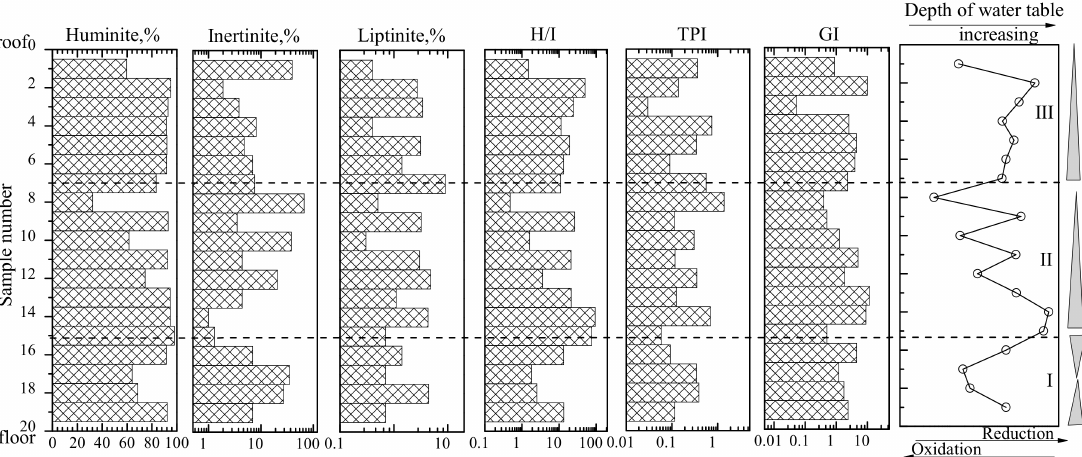
Figure 18. Vertical variations of the indices of the maceral and coal facies of the No. 5 coal